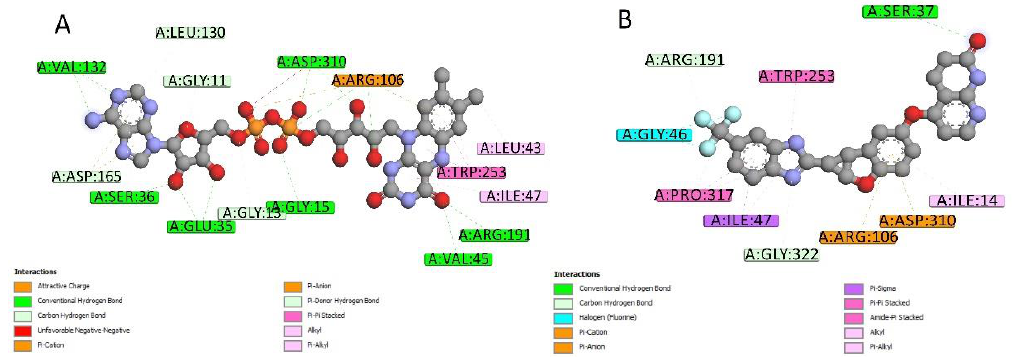
Figure 6. 2D ligand–protein interactions for Lifirafenib and co-crystallized ligand in phzG. ( A ) 2D interactions between FMN and phzG. ( B ) 2D interactions between Lifirafenib and phzG.